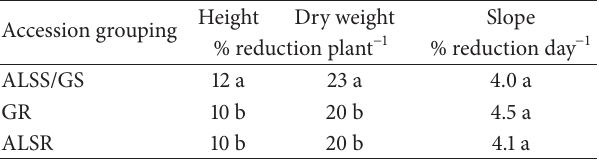
Data are pooled over experiments and duration of drought stress. Means within a parameter followed by the same letter are not significantly different according to Fisher’s protected LSD test at 𝑃 ≤ 0.10 .